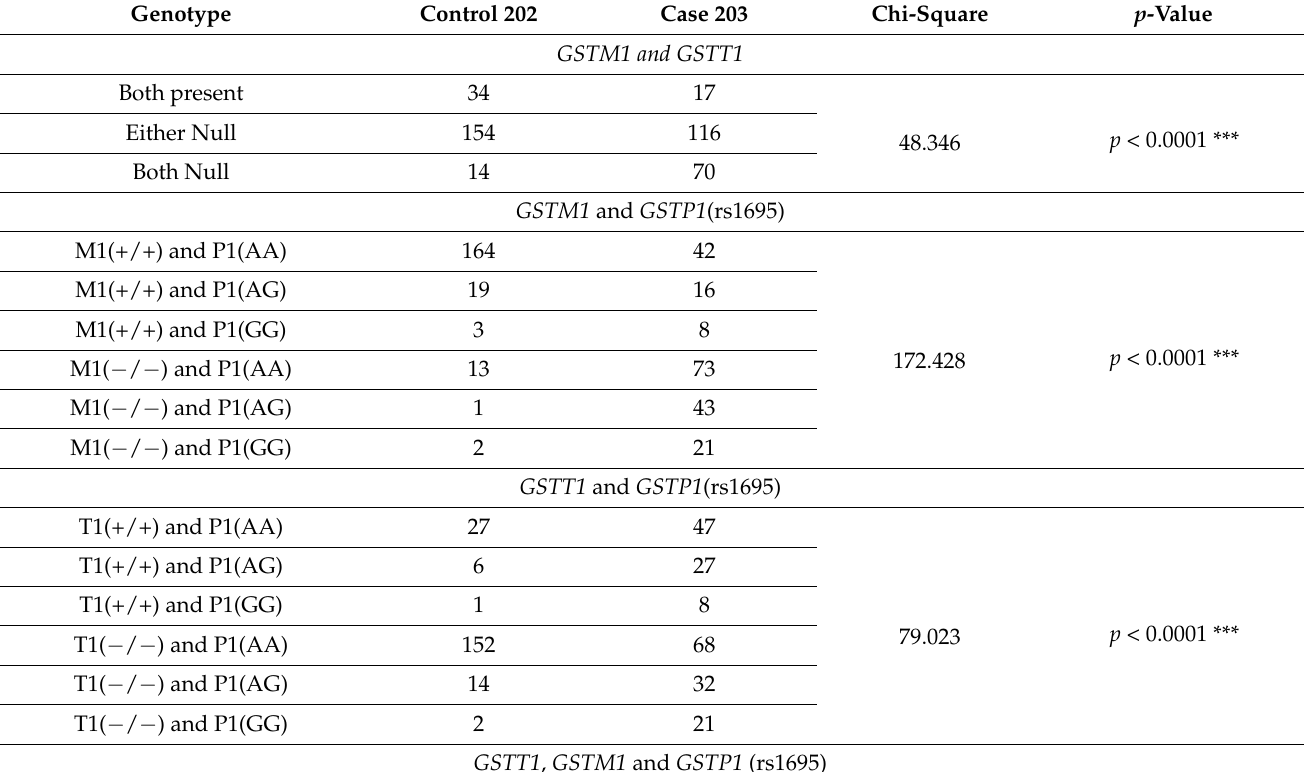
Table 3. Genotype and allelic frequency distribution among case and control subjects for combinations of GSTs and their possible association with chronic periodontitis. The chi-square test was applied to compare the genotype and allelic frequency between the case and control